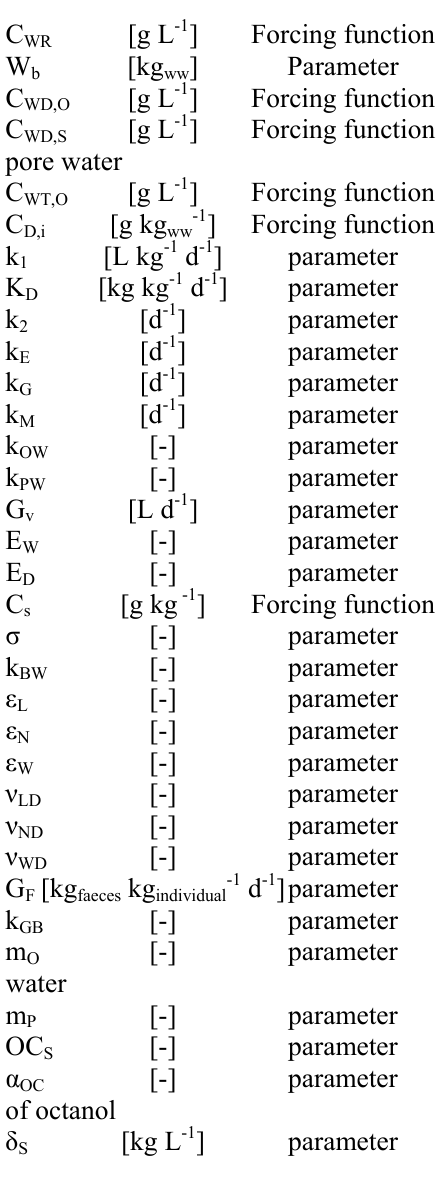
Table A.2. List of variable, forcing and parameters of the bioaccumulation